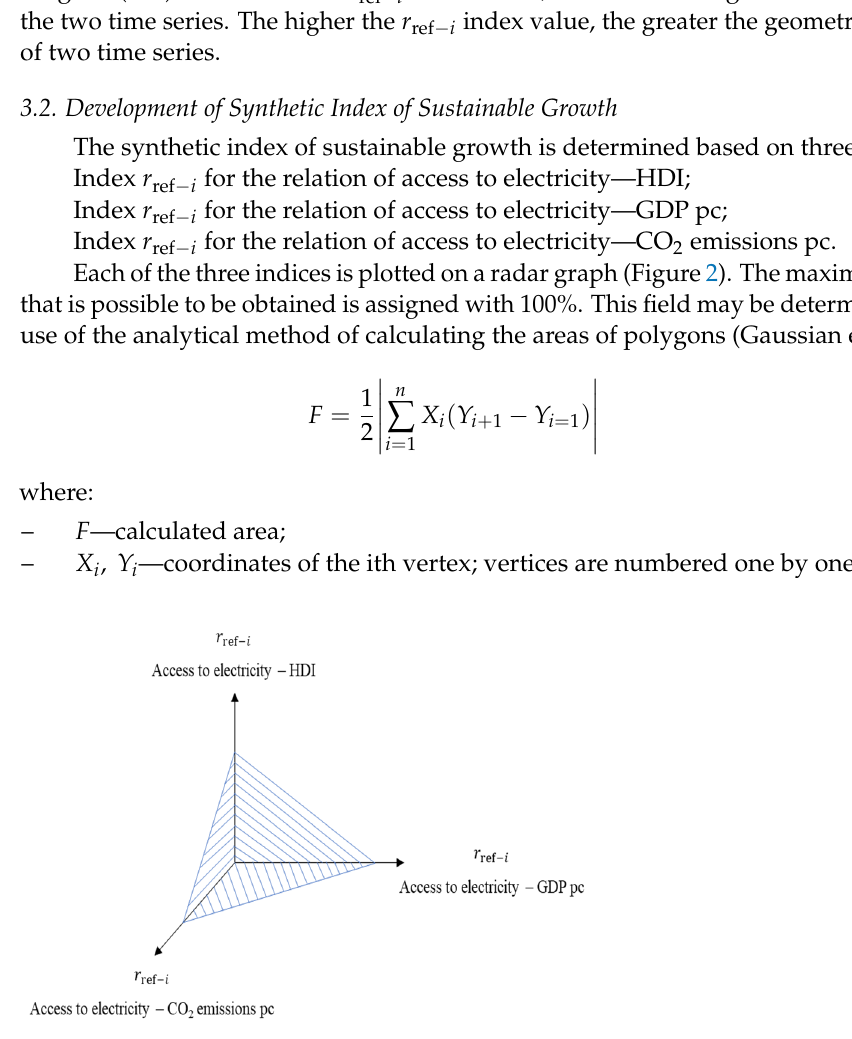
Figure 2. Graphical interpretation of the synthetic index of sustainable growth. Source: own work.